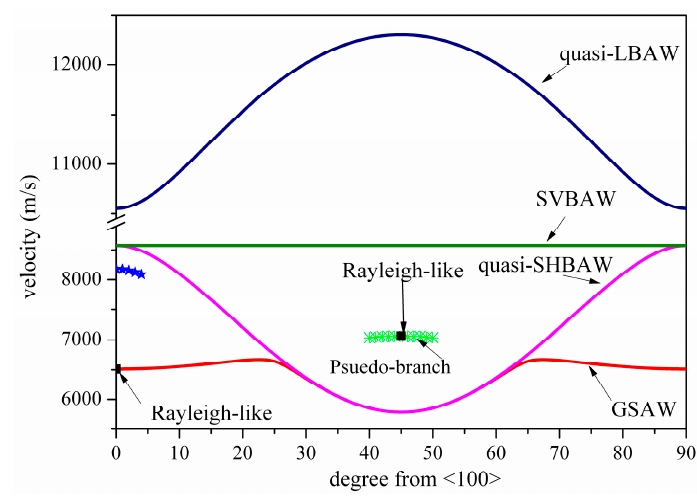
Figure 1. The angular dispersion of the BAWs and SAWs propagating in the (001) plane of 3C-SiC. At 0° and for few angles neighboring with this direction, the shear bulk wave satisfies the traction free boundary conditions: the wave travels at velocity v = 8181 m/s (the blue stars in Figure 1), and the particle displacement is in the sagittal plane, but it is not a surface wave since the wave amplitude does not decay with depth [12], as shown in Figure 2.